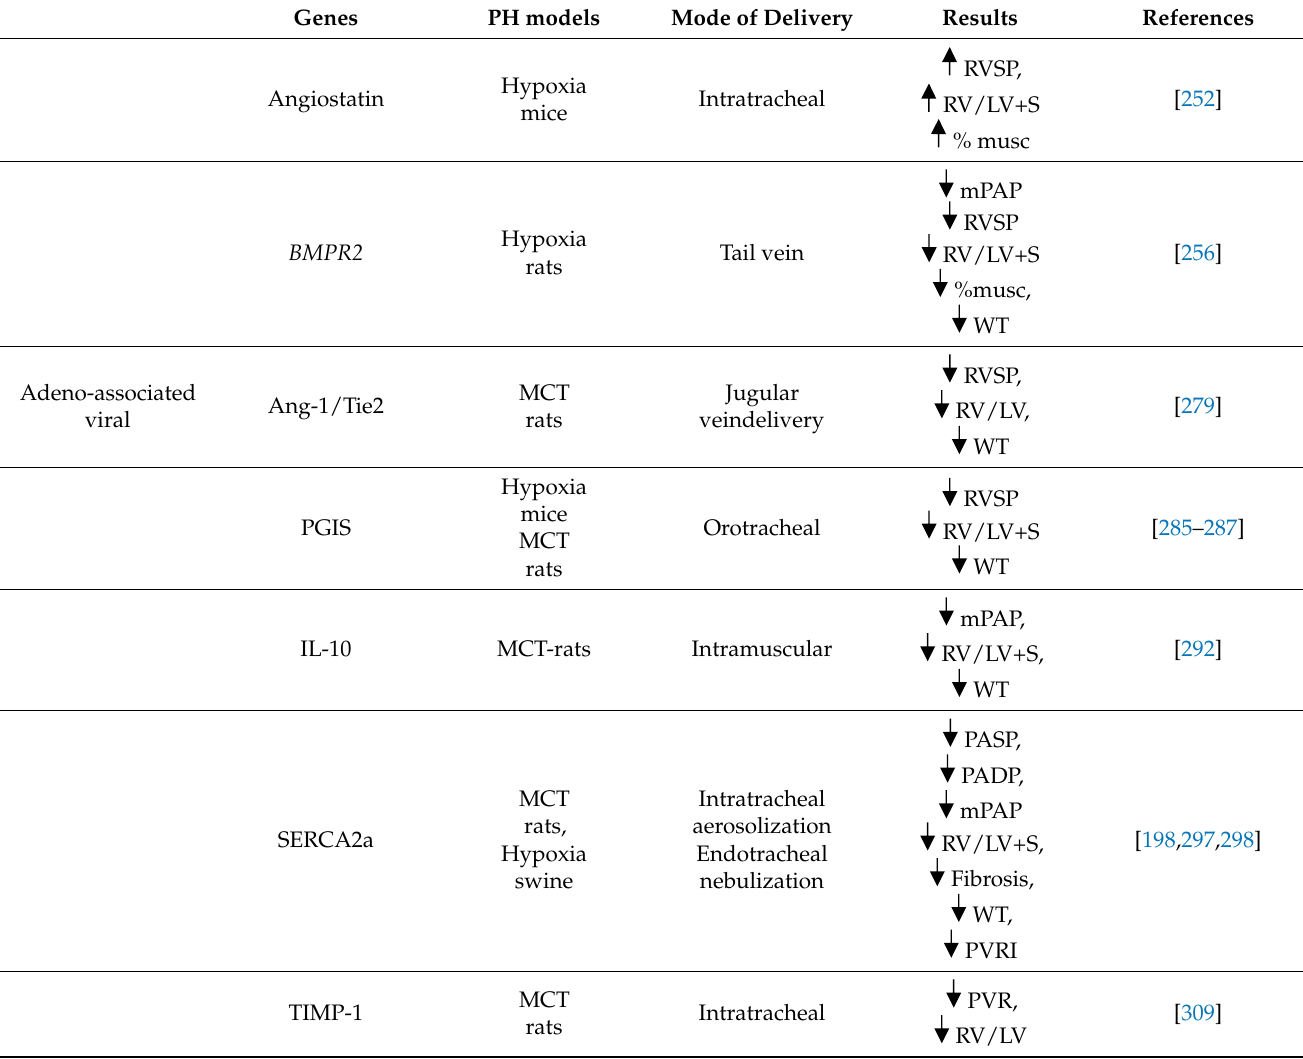
Table 1. An overview of different viral gene therapy approaches in pulmonary hypertension. Angiopoietin 1 (Ang-1); Bone morphogenetic protein receptor type 2 ( BMPR2 ); Cluster of differentiation 40 (CD-40); Calcitonin gene-related peptide (CGRP); Galectin-3 (Gal-3); Forkhead box O1 ( FoxO1 ); Hypoxia inducible factor-1 α (HIF-1 α ); Interleukin 10, (IL-10); Nitric Oxide (NO); Prostacyclin synthase (PGIS); Sarco-/endoplasmic reticulum calcium-ATPase 2a (SERCA2a); Tissue inhibitor matrix metalloproteinase 1 (TIMP-1); Transgelin ( Tagln ); Tryptophan hydroxylase-1 ( Tph1 ); Tyrosine-protein kinase receptor (Tie2); Twist related protein 1 (Twist); Vascular endothelial growth factor (VEGF); Voltage-gated potassium channel member 5 (Kv1.5); Mean pulmonary arterial pressure (mPAP); right ventricular systolic pressure (RVSP); ratio of right ventricular weight to left ventricle plus septum (RV/LV+S); wall thickness (WT); pulmonary arterial systolic pressure (PASP); pulmonary arterial diastolic pressure (PADP);% of muscularization of pulmonary arteries (% musc); pulmonary vascular resistance index (PVRI).